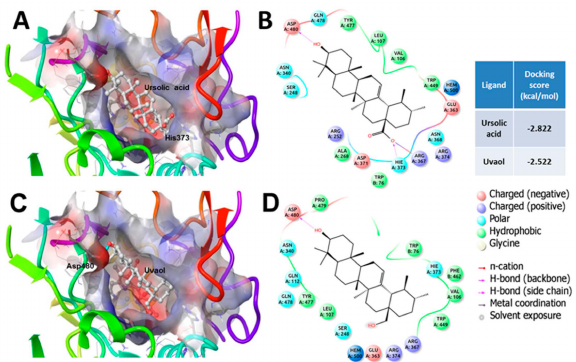
Figure 9. Binding mode of ursolic acid and uvaol into the eNOS binding site: ( A ) short interactions (4.5 Å) of ursolic acid into the C1 and C2 pockets; ( B ) 2D ligand interaction diagram of ursolic acid; ( C ) Short interactions (4.5 Å) of uvaol into the C1 and C2 pockets; and ( D ) 2D ligand interaction diagram of uvaol.